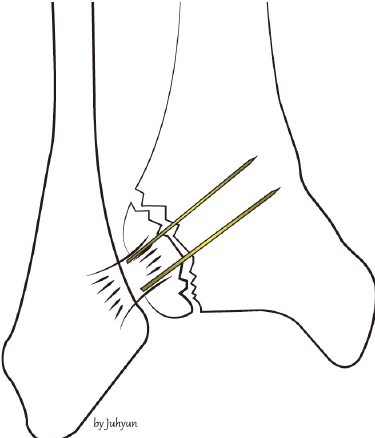
Medicina 2022 , 58 , x FOR PEER REVIEW Figure 2. After the Chaput fracture has been reduced, two K-wires and screws are fixed.